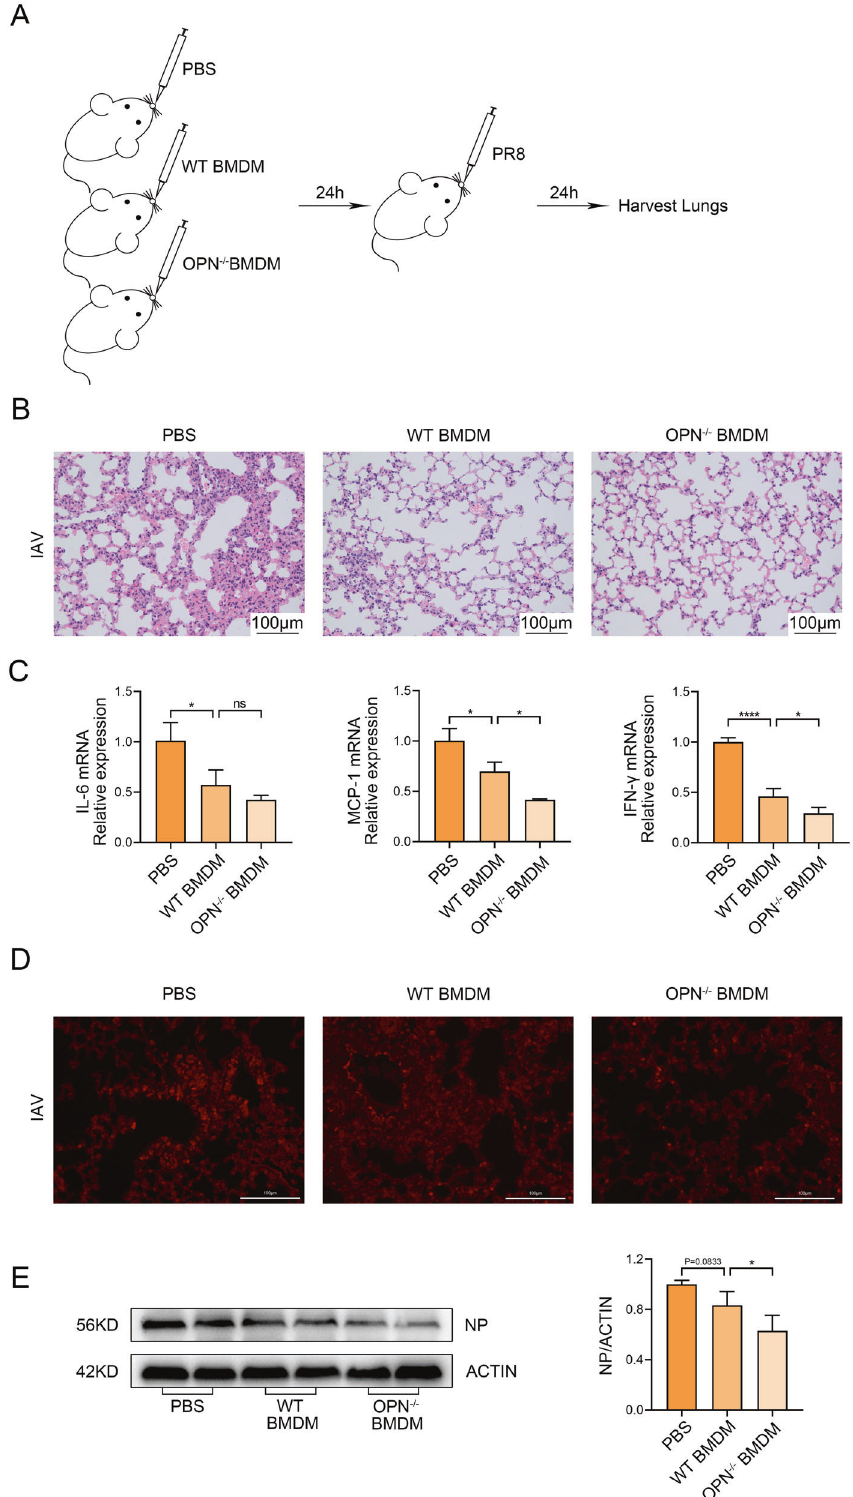
Fig. 5 Adoptive transfer of OPN − / − BMDM reduces tissue injury in mice induced by subsequent PR8 infection. A – E WT or OPN − / − BMDMs were intranasally transferred to WT recipient mice. One day after transfer, mice were infected with PR8 (1.5 × 10 3 PFU/animal) and lung tissues were collected 24 h after infection. A Diagrammatic representation of adoptive transfer. B Serial lung sections of representative lungs stained with hematoxylin and eosin, scale bar = 100 μ m. C In fl ammatory factor (IL-6, MCP-1, and IFN- γ ) levels in lung homogenates were measured using qPCR. D Representative images of immuno fl uorescence staining for P-MLKL in the lung. E Lung homogenates were collected and subjected to western blot analysis. Each lane corresponds to an individual mouse. Lane-loading differences were normalized by levels of ACTIN. Data was analyzed by one-way ANOVA and expressed as mean ± SEM. n = 3-4/group. * p < 0.05; **** p < 0.0001; ns denote no statistical signi fi cance.